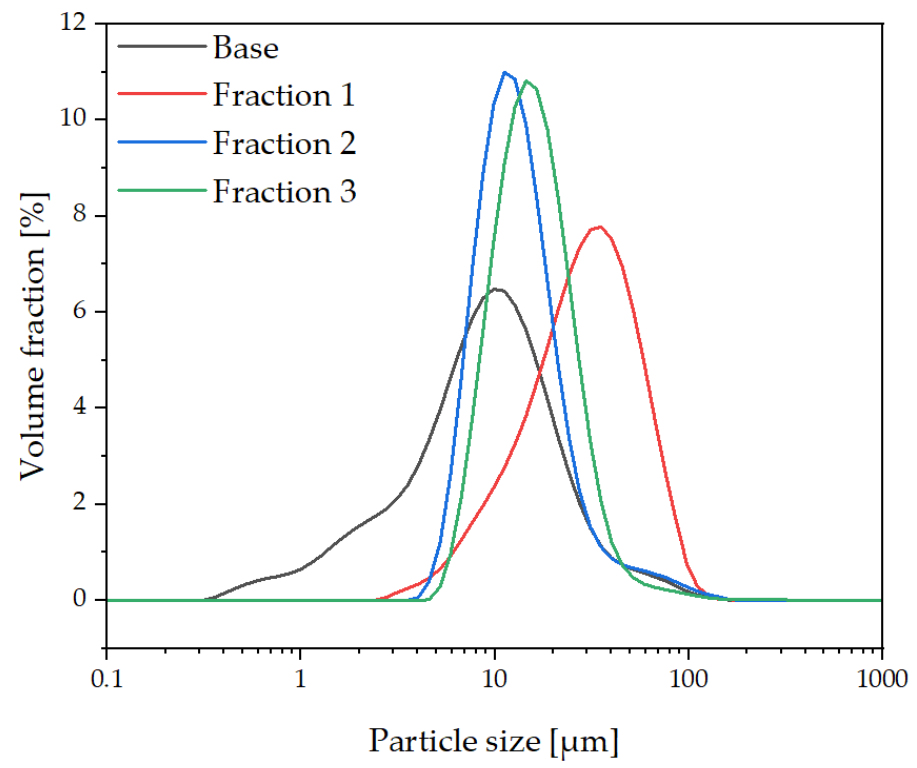
Figure 6. Particle size distribution of fractionated diatomite .